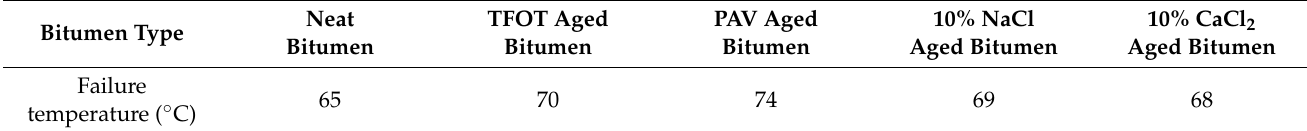
Table 6. The failure temperature of five kinds of bitumen.